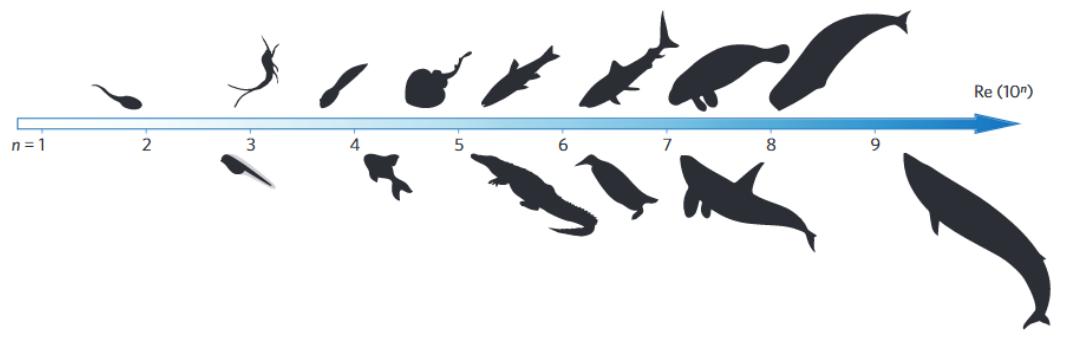
Figure 7. Reynolds number for several organisms [151]. Figure